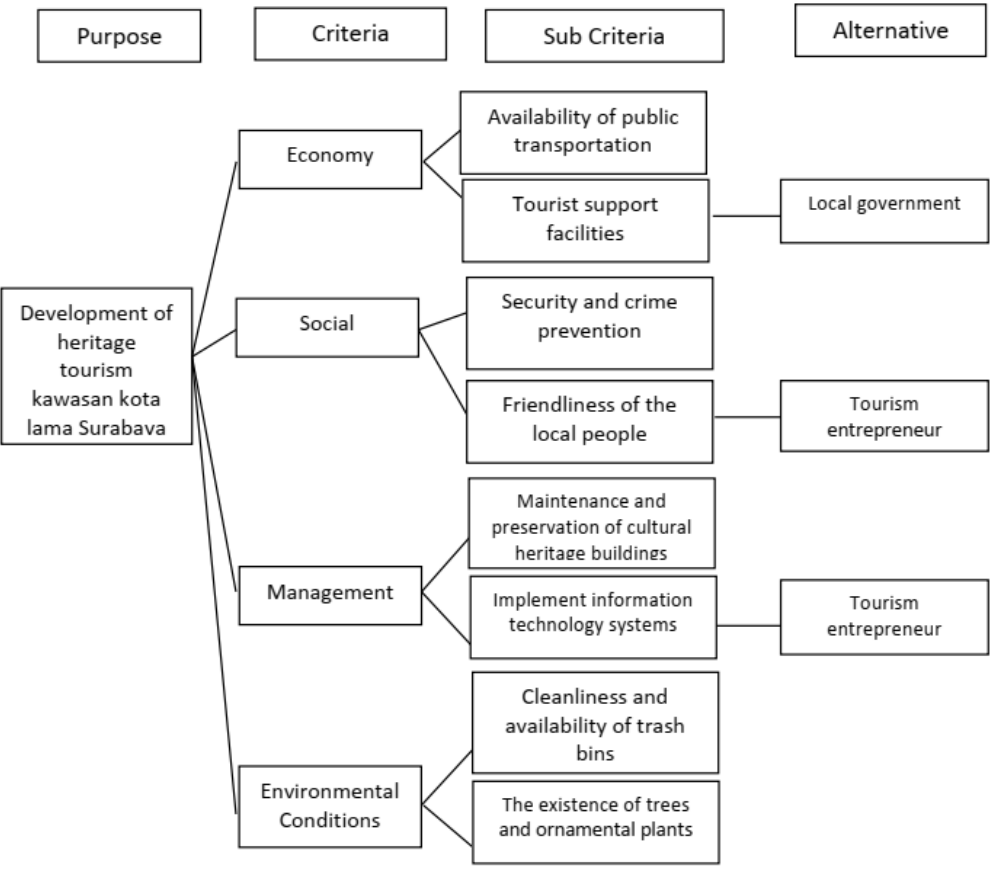
Figure 1: Hierarchical Structure Determination of Heritage Tourism Development Policy Priority (Ngamsomsuke, et al., 2011)